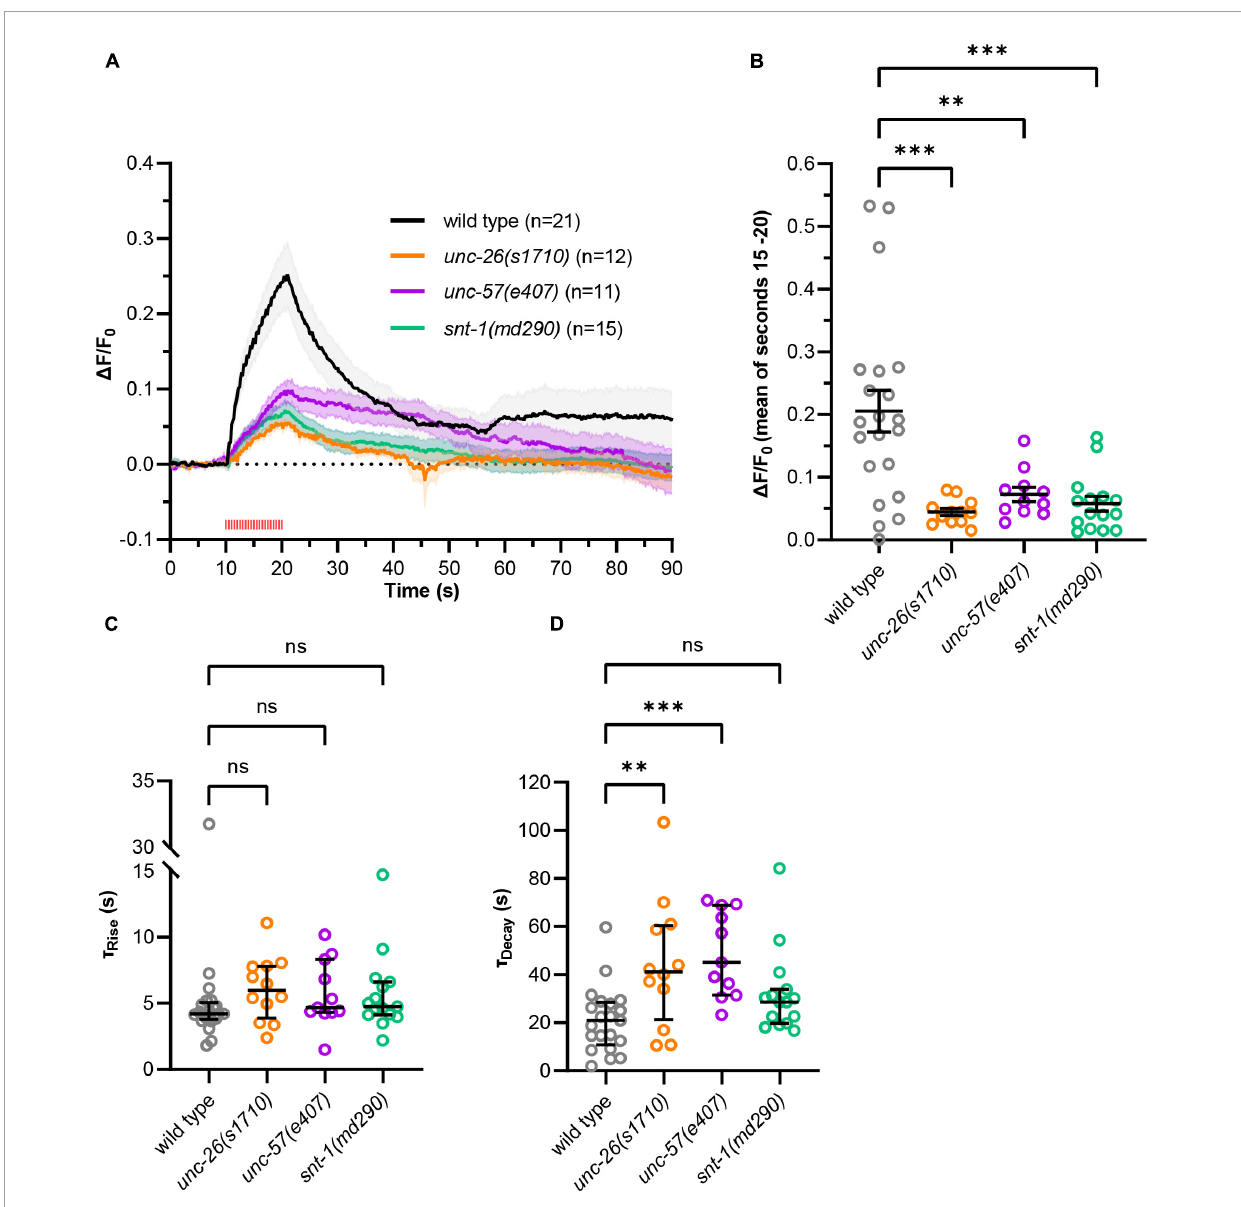
FIGURE4 Using pulsed, more physiological optogenetic stimulation. (A) As in Figure 3 , but using 2 Hz pulsed light stimulation (100 ms pulses, 590 nm, 40 µ W/mm 2 , red tick marks) applied after 10 s for 10 s. Using this stimulation regime, more animals were excluded from analysis [wild type: 17 of 38 animals, unc-26(s1710) : 18 of 30, unc- 57 (e406) : 22 of 33, snt-1(md290) : 39 of 54] accumulated from N = 5–6 biological replicates. (B) Fluorescent signal of individual wild type and mutant animals at the end of stimulation (15–20 s). Mean ( ± SEM). One-way ANOVAs with Dunnett’s correction ( ∗∗ p < 0.01, ∗∗∗ p < 0.001). (C) Calculated fluorescence rise constants of single animals using a one-phase exponential fit during stimulation (10–20 s). Median with interquartile range. Kruskal–Wallis test with Dunn’s correction ( ns p > 0.05). (D) Calculated fluorescence decay constants of single animals using a one-phase exponential fit after stimulation (20–90 s). Median with interquartile range. Kruskal–Wallis test with Dunn’s correction ( ns p > 0.05, ∗∗ p < 0.01, ∗∗∗ p <